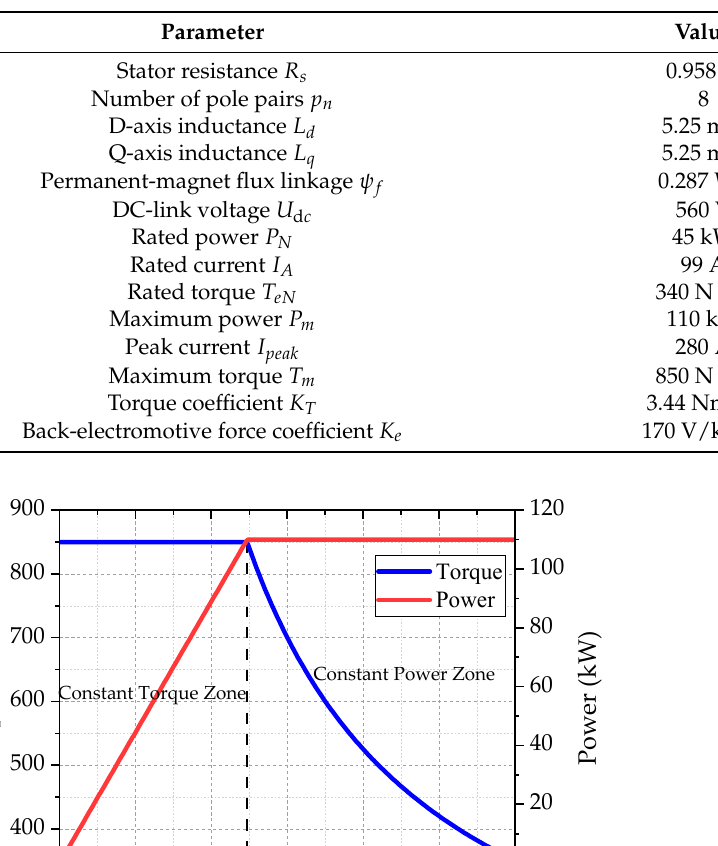
Table 2. PMSM parameters.